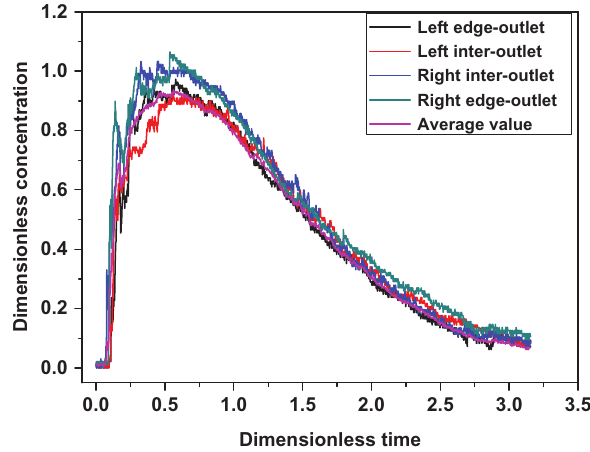
Figure 13: RTD curves in tundish with new designed porous